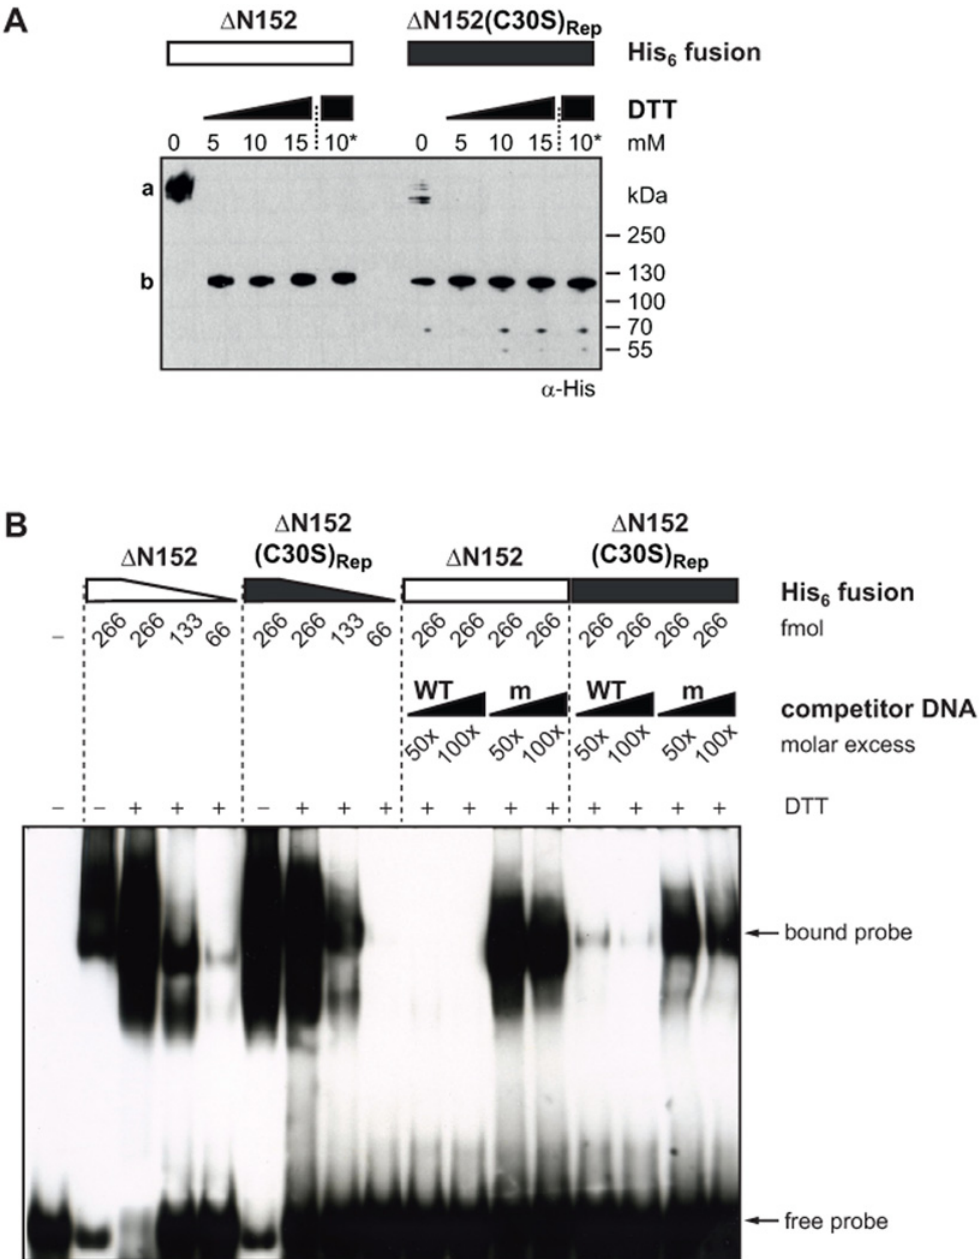
Fig 3. The AvrBs3 cysteine mutant is monomeric and binds specifically to DNA in vitro . ( A ) 0.5 μ g purified His 6 ::AvrBs3 Δ N152 and His 6 :: AvrBs3 Δ N152(C30S) Rep , respectively, were treated with different concentrations of DTT for 1 h at RT or with 10 mM DTT overnight at 8°C (10 * ). Samples were separated by a non-reducing SDS-polyacrylamide gel and analyzed by immunoblot with an α -His antibody. a, multimeric His 6 ::AvrBs3 Δ N152; b, monomeric His 6 ::AvrBs3 Δ N152. ( B ) EMSA. 333 fmol biotin-labeled 36-bp DNA-fragments derived from the UPA20 promoter were incubated with reduced His 6 ::AvrBs3 Δ N152 and His 6 ::AvrBs3 Δ N152(C30S) Rep (+, incubation with 10 mM DTT overnight). Unlabeled WT and mutant ubm2 DNA fragments (m, [8]) were used as competitor DNA. The experiments were repeated at least twice with similar results.